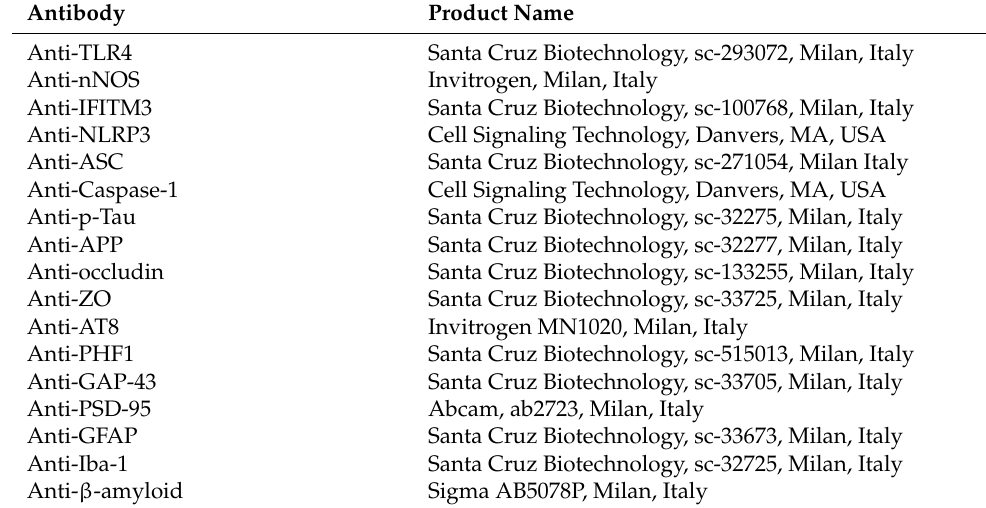
Table 1. Primary